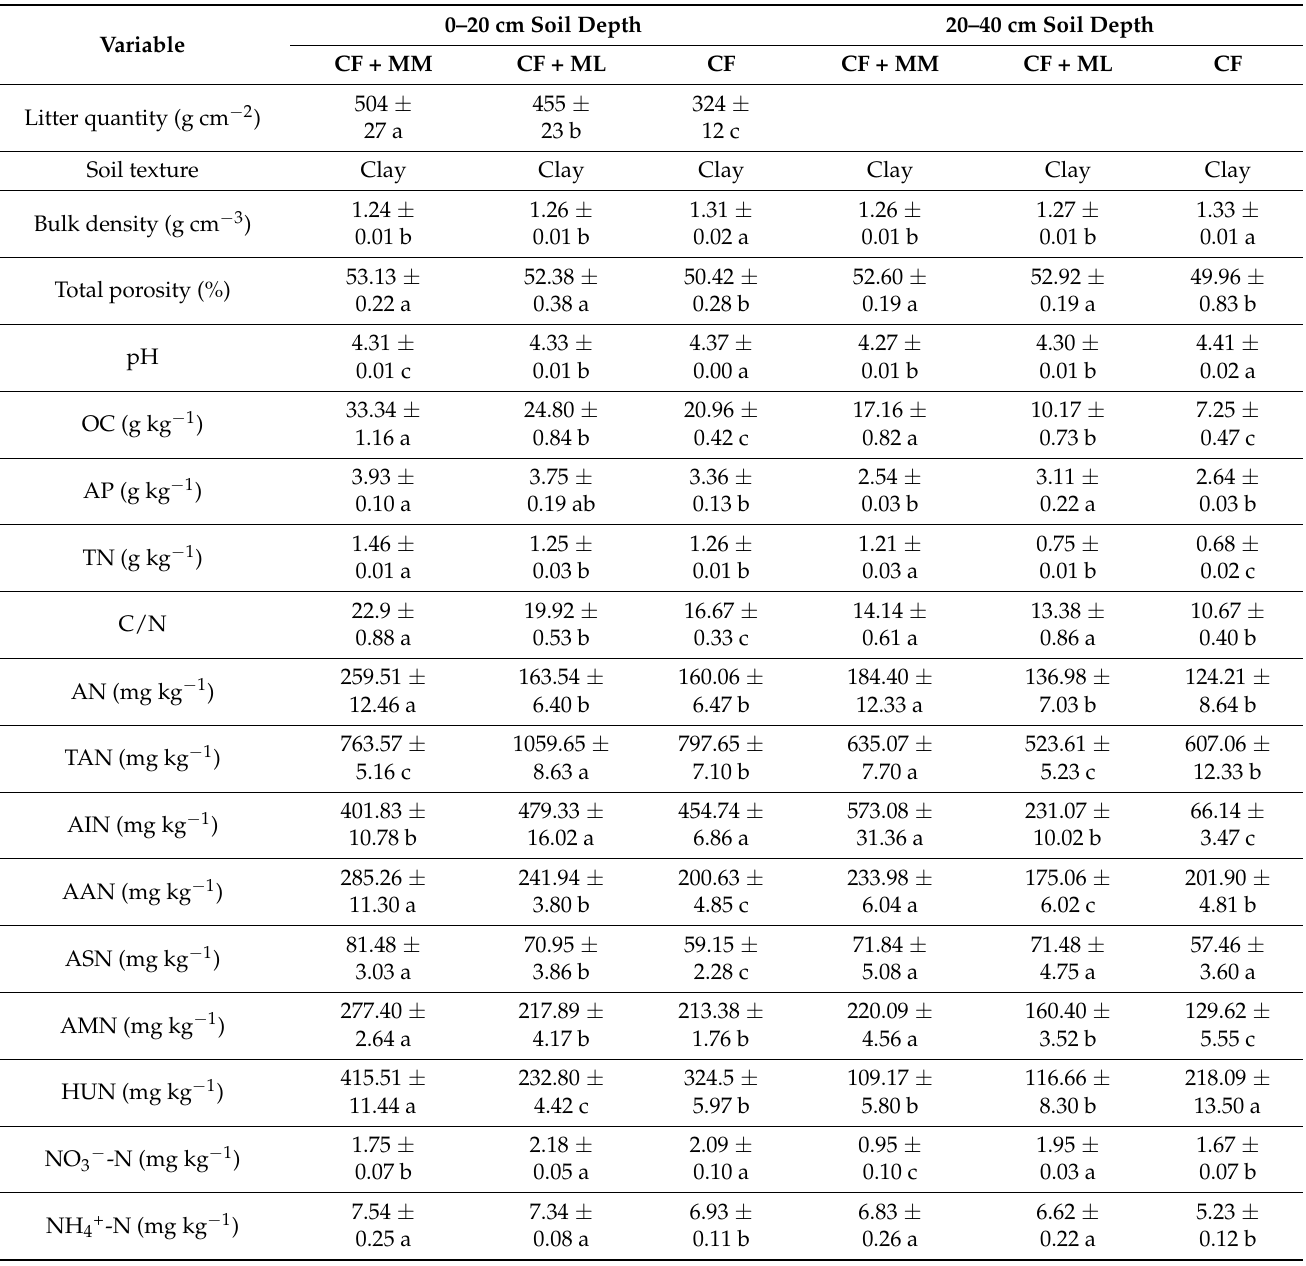
Table 2. Litter and bulk soil